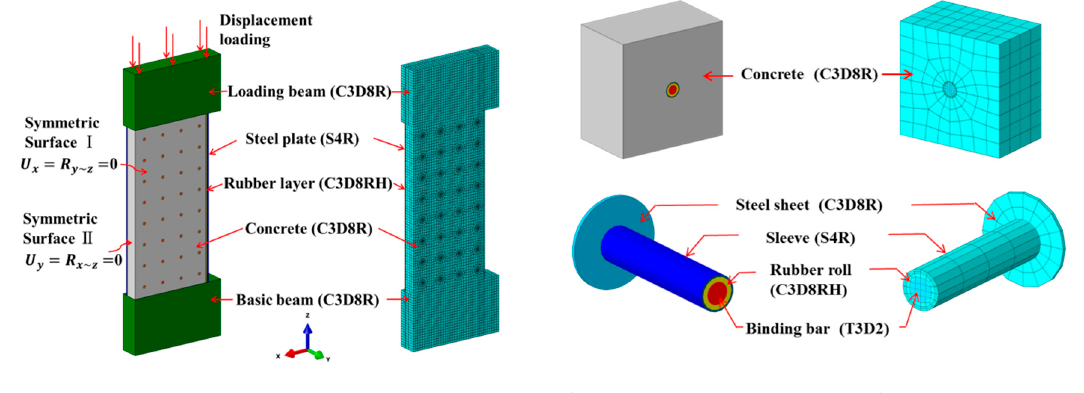
Figure 5. Finite element (FE) models for the SDC wall.